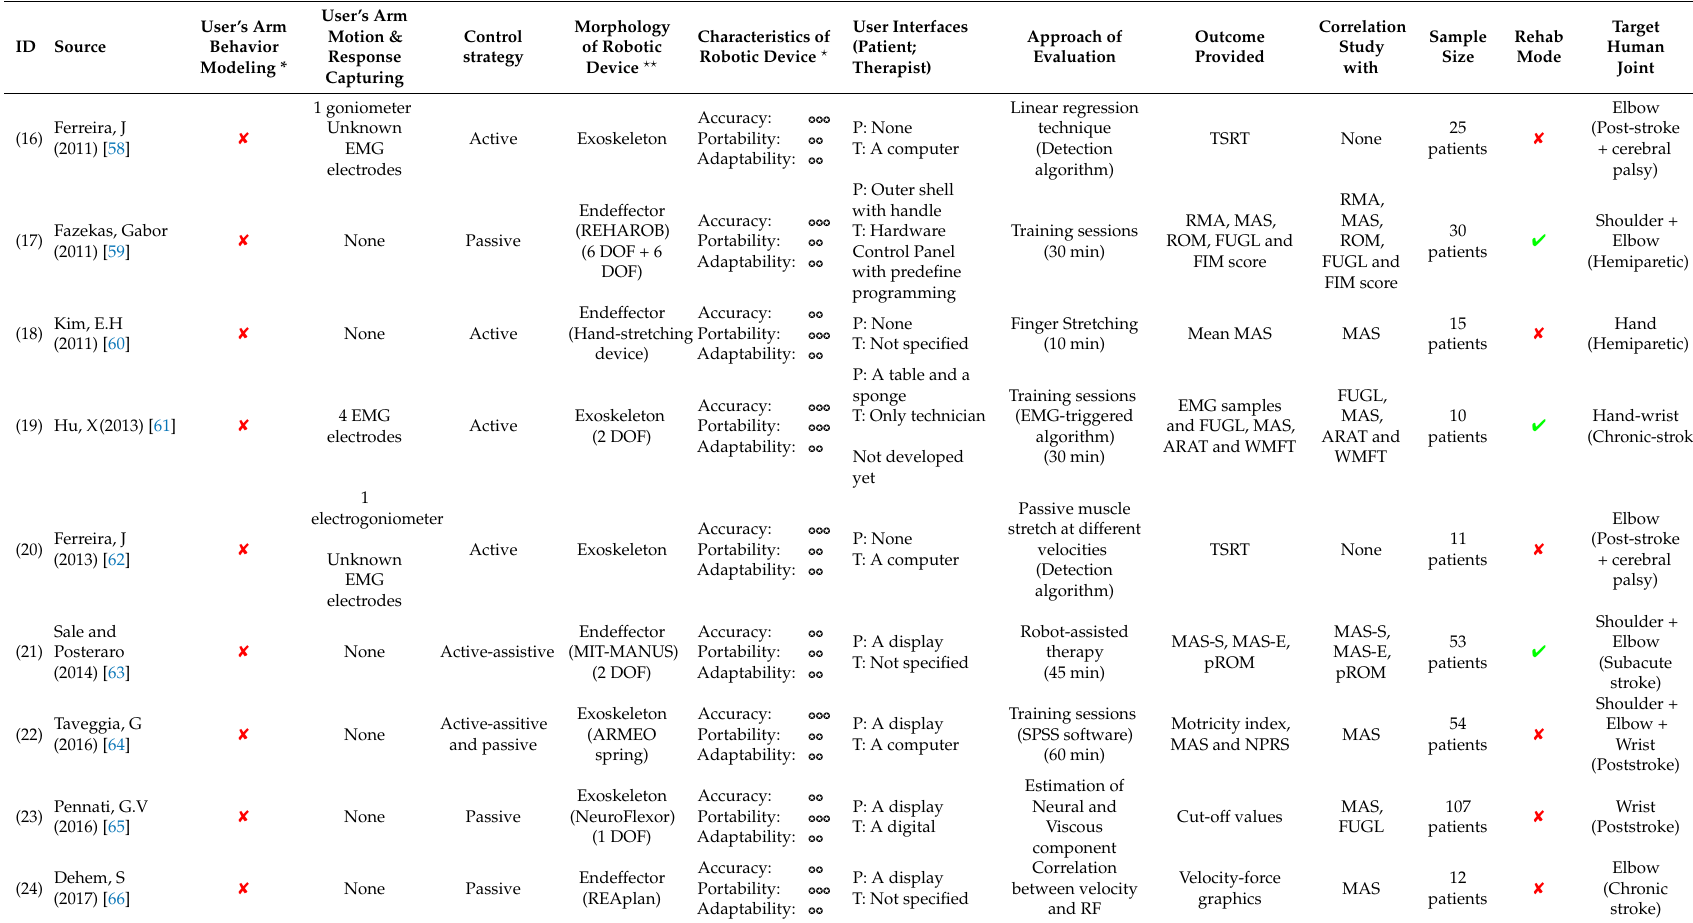
P: A table and a